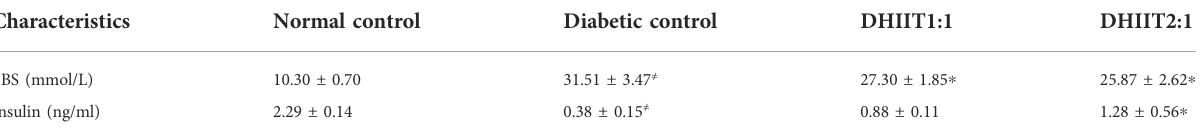
TABLE 3 The plasma characteristics of the rats at the end of the fourth